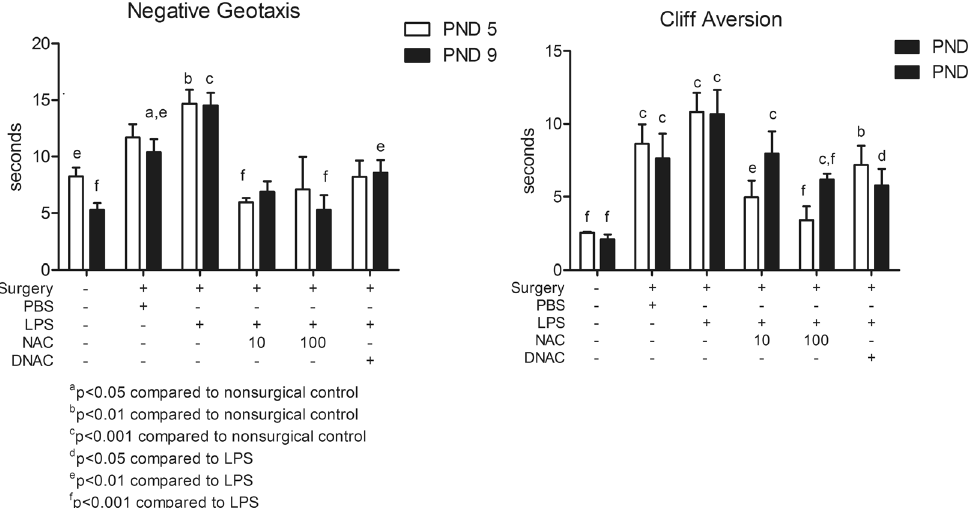
Figure 6. Neuromotor and developmental behavioral changes in response to intrauterine exposure to LPS. Surviving offspring were tested on postnatal day (PND) 5 and 9 to assess neurodevelopmental milestones using negative geotaxis and cliff aversion tests. Prenatal lipopolysaccharide (LPS) exposure induced significant changes in negative geotaxis and cliff aversion test performance in LPS groups at PND 9. Maternal treatment with dendrimer N -acetyl- L -cysteine (DNAC) significantly improved negative geotaxis behavior at PND 5 and 9, compared to surgery + LPS. Cliff aversion test performance for treated pups was similar to non-surgical control litters at PND9. (Generalized Estimating Equations with pair-wise Bonferroni post-hoc tests; n = 18 PBS litters, 27 LPS litters; 17 LPS + DNAC litters; 4 PBS + DNAC litters; 14 LPS + NAC10 litters; 6 LPS + NAC100 litters; 14 Control